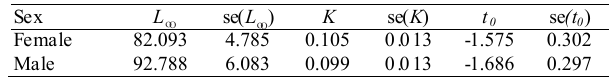
Table 3. Von Bertalanffy growth parameters estimates for female and males of the dog snapper Lutjanus jocu from Abrolhos Bank. The age is the average age between reading 1 and 2 (se = Standard error).